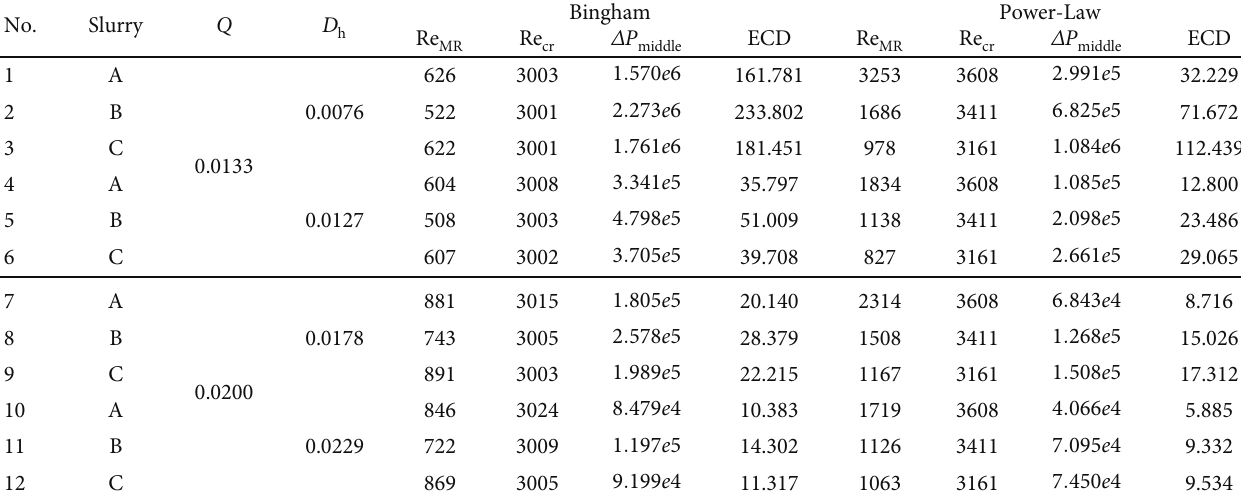
Table 3: ECD calculations for annuli with di ff erent radial sizes and rheological models.